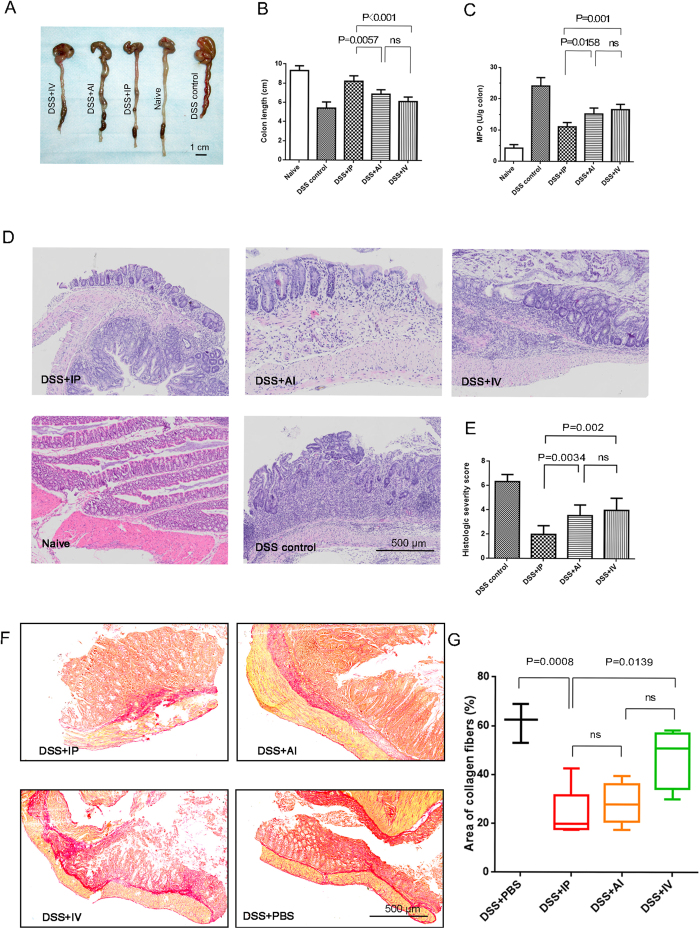
Histopathological comparison of colitis after 3 days MSCs delivery.(A,B) Representative colon images and quantification of colon length; (C) myeloperoxidase (MPO) activity in colonic protein extracts; (D,E) Representative H&E staining and corresponding severity score; (F,G) Representative sirius red staining and quantification of collagen deposition. Horizontal bars represent medians, boxes represent the 25th and 75th percentiles. n = 6–8 mice/group; n = 3 for the control and naive (health mice) group.